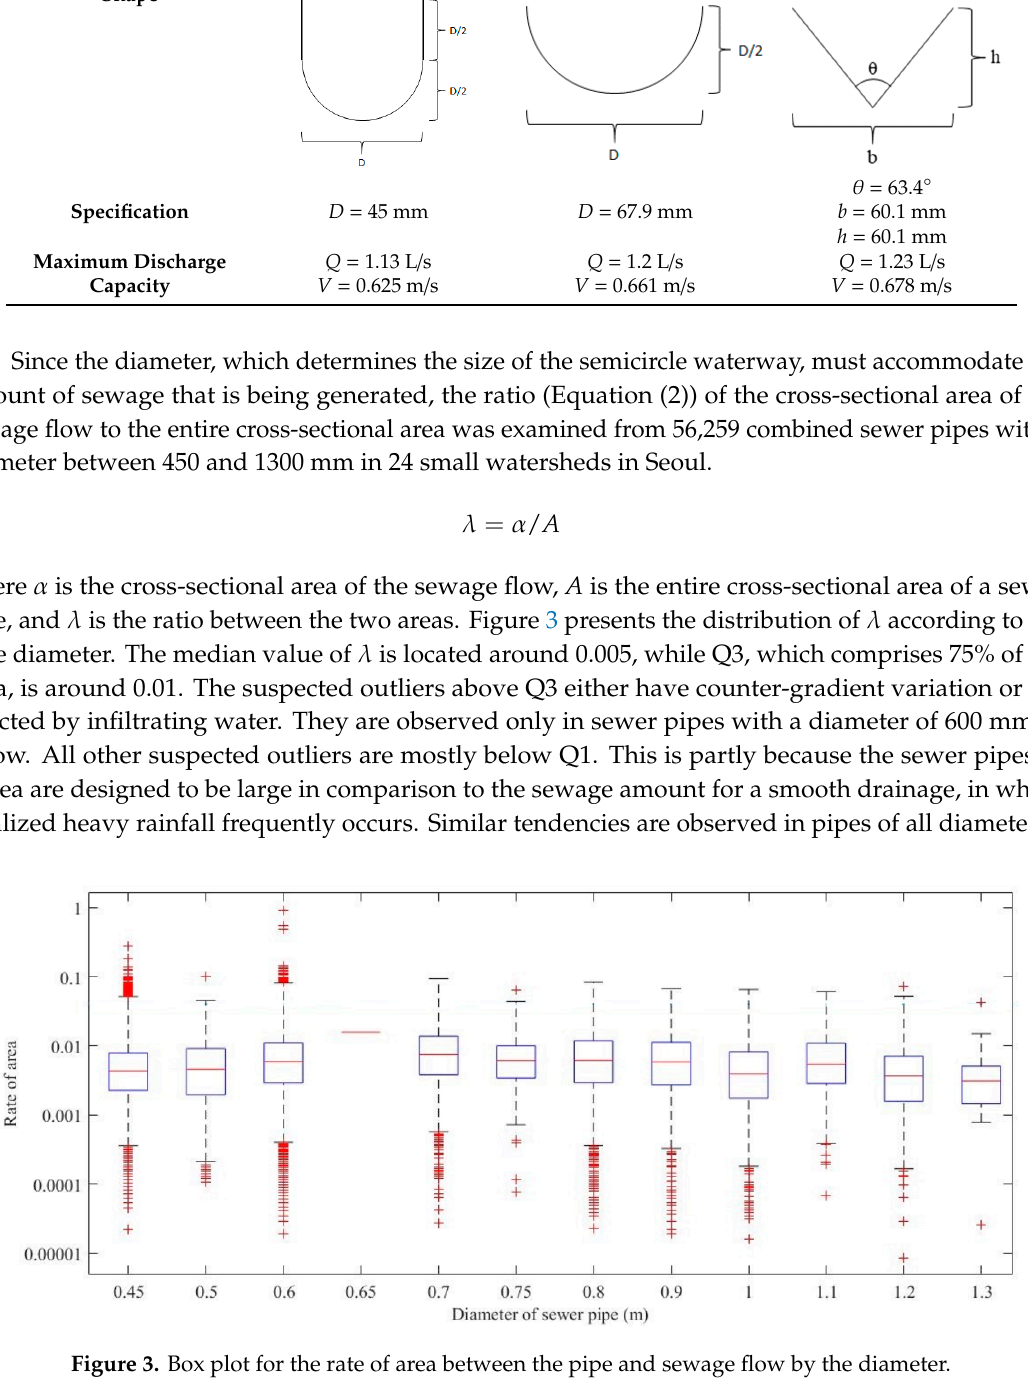
Figure 3. Box plot for the rate of area between the pipe and sewage flow by the